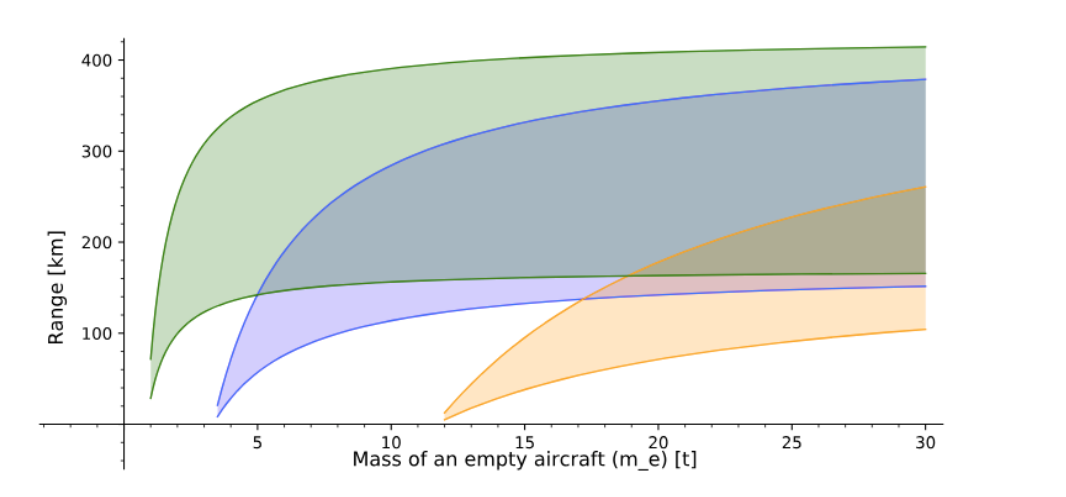
Figure 1. Estimated empty mass of an a battery-driven electric aircraft, in dependence of its achievable range, with similar design concept as a conventional aircraft and with: ( green ) 500kg of payload and crew; ( blue ) 2000kg of payload and crew; and ( orange ) 7000kg of payload and crew. The shaded area represents the solution for batteries with a specific energy in range of 0.1–0.25kWh/kg, with the assumption that all energy is used only for